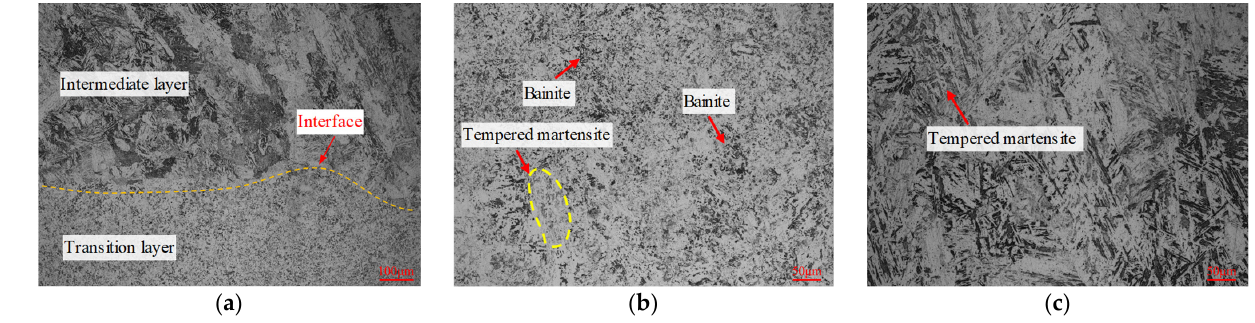
Figure 8. Microstructure of interface B. ( a ) Interface B (position 4). ( b ) Transition layer (position 5). ( c ) Intermediate layer (position 6).